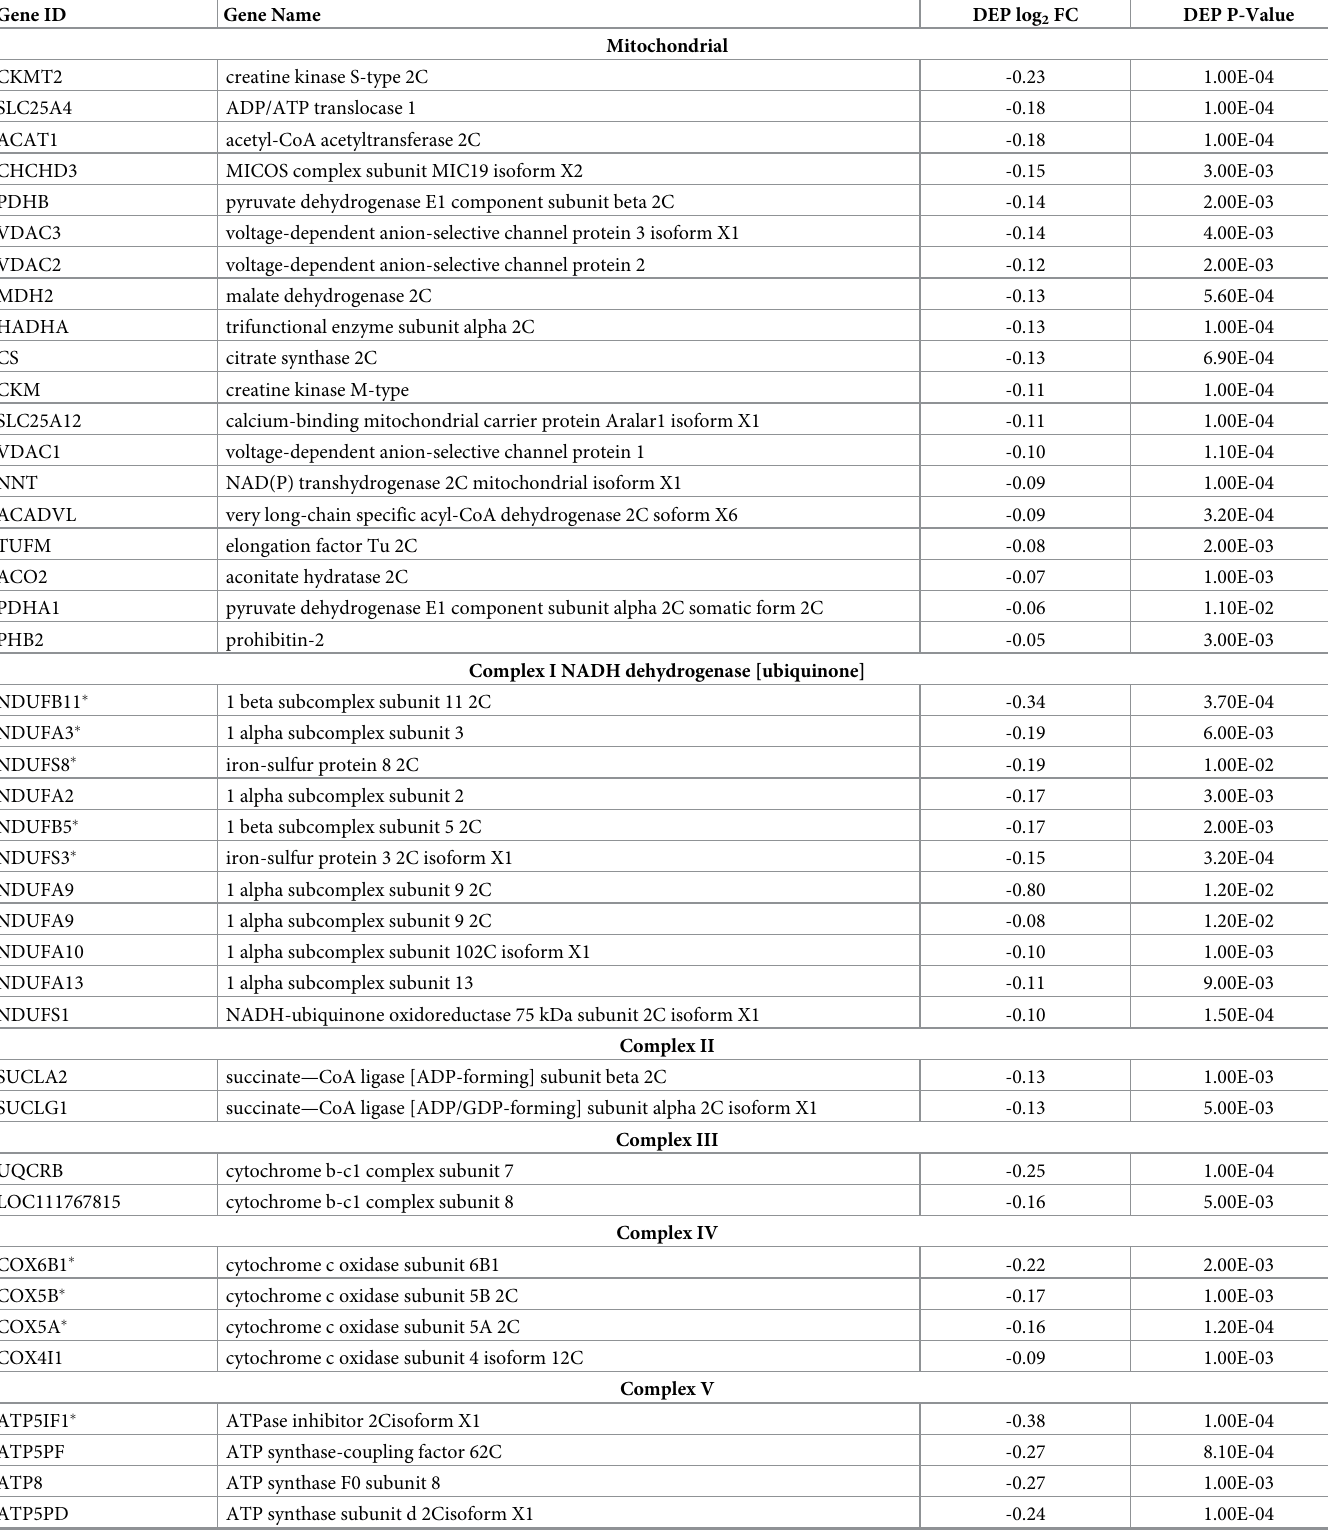
Table 3. Differentially expressed mitochondrial proteins (DEP) with decreased expression comparing horses susceptible to recurrent exertional rhabdomyolysis with control. Gene